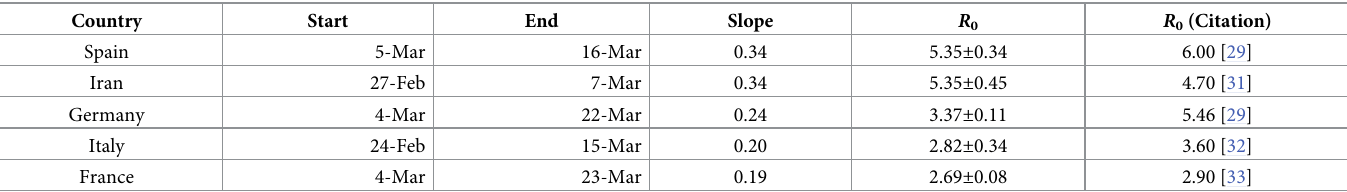
Table 2. Initial exponential growth r estimated by regime regression.